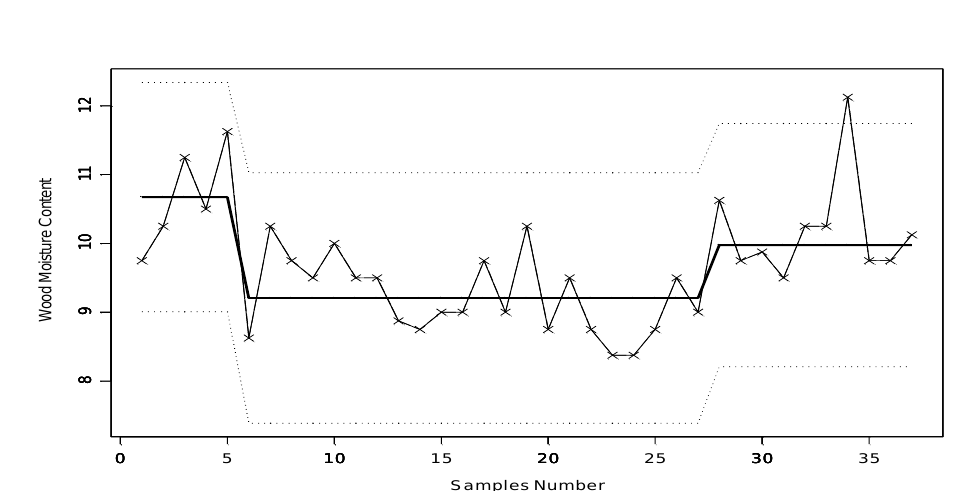
Fig. 3. Robust individuals control chart for wood moisture content using MAD estimator.